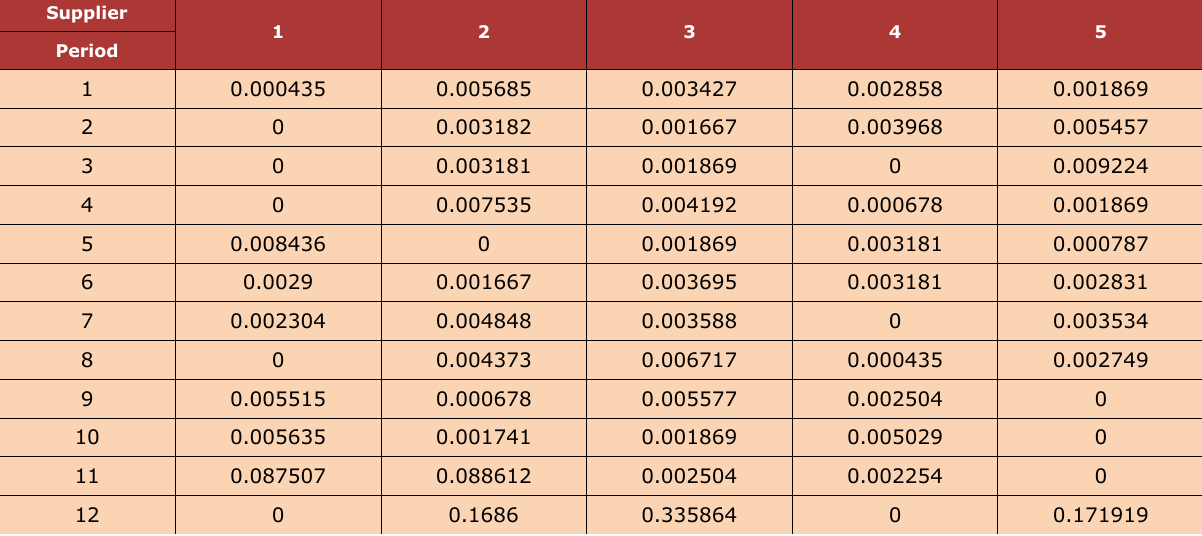
Table 20. Results of portfolio variables (Fit) resulted from NSGA-II